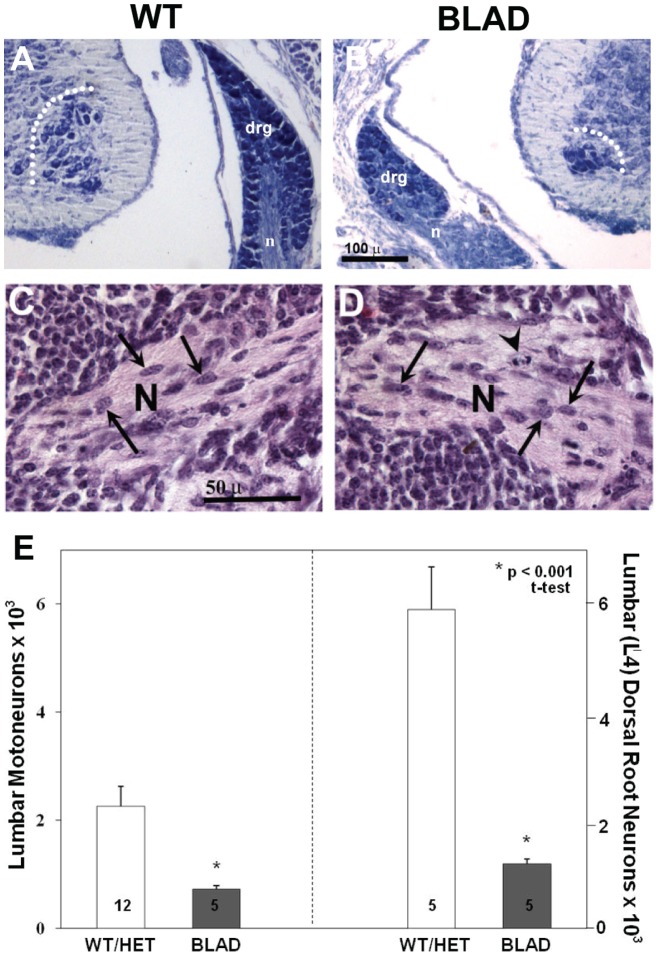
Spinal cord and dorsal root ganglion(DRG). (A, B) Transverse sections of the lumbar spinal cord of wild-type (WT) and Nmnat2blad/blad (BLAD) mice at E18.5. Lumbar motoneurons in the spinal cord, sensory neurons in the DRG and the size of DRG are markedly reduced in BLAD mice at E18.5. (C, D) Peripheral nerves (N) from E18.5 WT (C) and BLAD (D) embryos in a lumbar region similar to that indicated by the arrows in Figures 6A–B. The lightly stained regions contain axons and the dark cells in the nerve (arrows) are presumptive Schwann cells. (E) Values (Mean ± SD) for neuron numbers for WT and Nmnat2blad/+ (HET) mice did not differ and have been combined for comparison with BLAD. DRG, dorsal root ganglion; n, nerve; dotted line encloses motoneurons in the ventral horn.